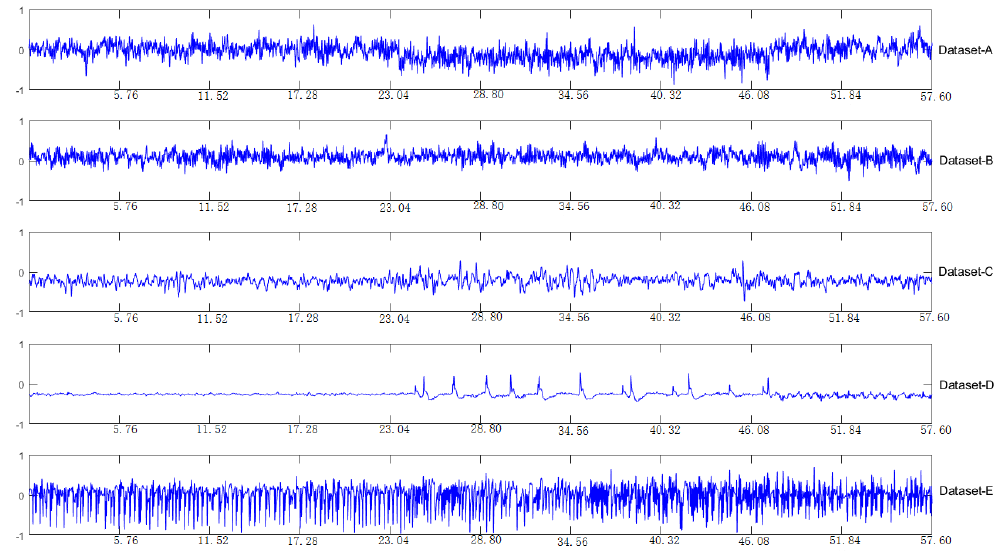
Figure 1. Typical electroencephalographic (EEG) segments from each of the five datasets ( A – E